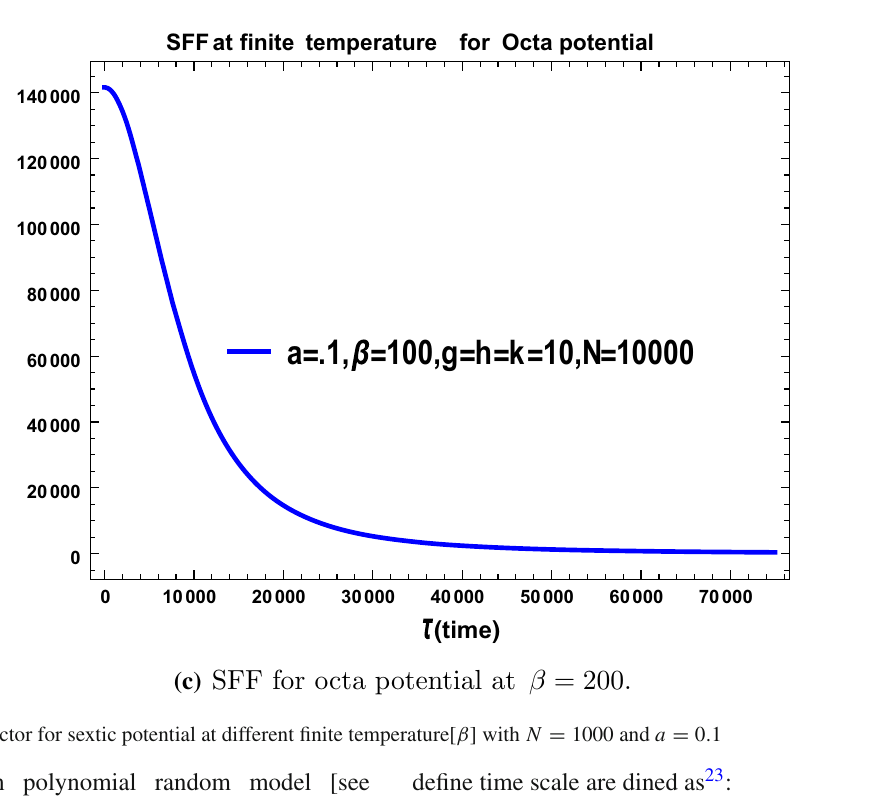
Fig. 32 Spectral Form Factor for sextic potential at different finite temperature[ β ] with N = 1000 and a = 0 . 1 For different even polynomial random model [see Eqs. (5.150), (5.170), (5.193), (5.215)], we see that the